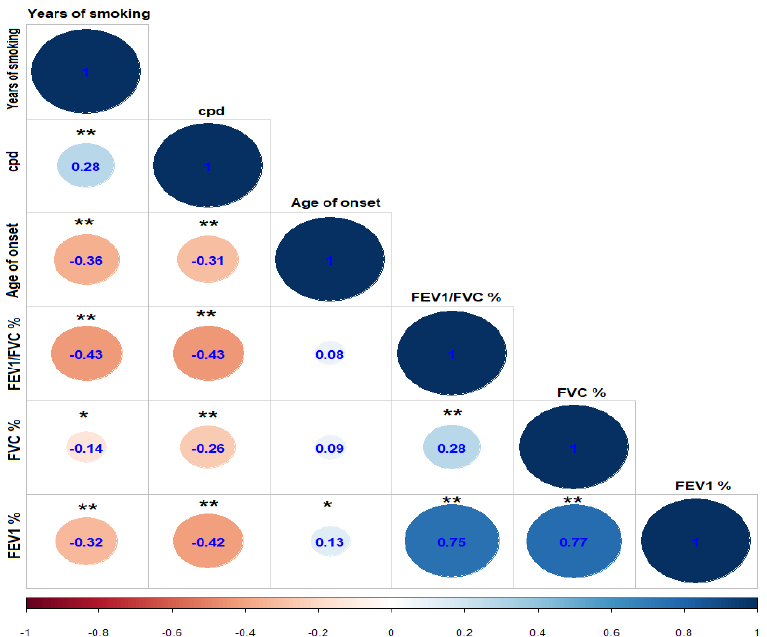
Figure 1. Correlogram between quantitative variables of the three groups included in the study, showing Spearman’s rho. * p < 0.05. ** p ≤ 0.01. FEV 1 , FVC, and FEV 1 / FVC values are shown post-bronchodilator. Abbreviations: cpd: cigarettes per day; FVC: forced vital capacity; FEV 1 : forced expiratory volume in the first